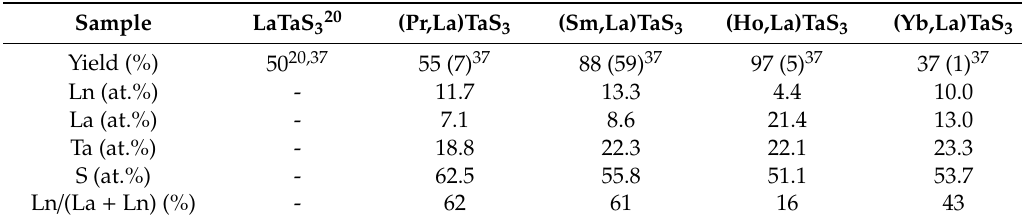
Table 2. Yield and results of the energy dispersive X-ray spectroscopy (EDS) (TEM) quantification In parentheses—the yield for the pure LnS-TaS 2 nanotubes